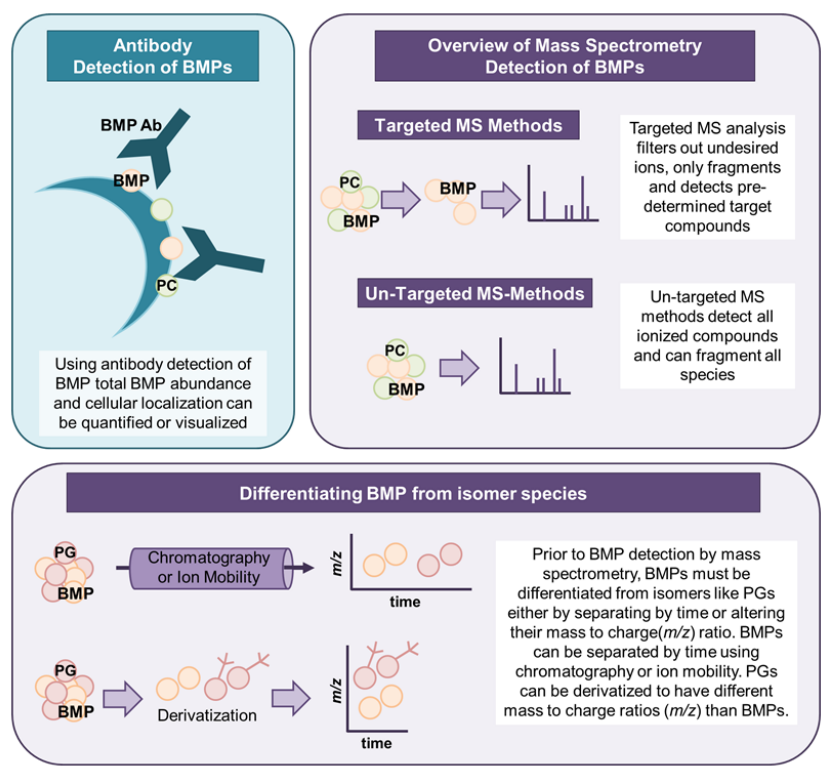
Figure 2. Overview of the detection methods for BMPs. BMPs can be analyzed by antibody detection